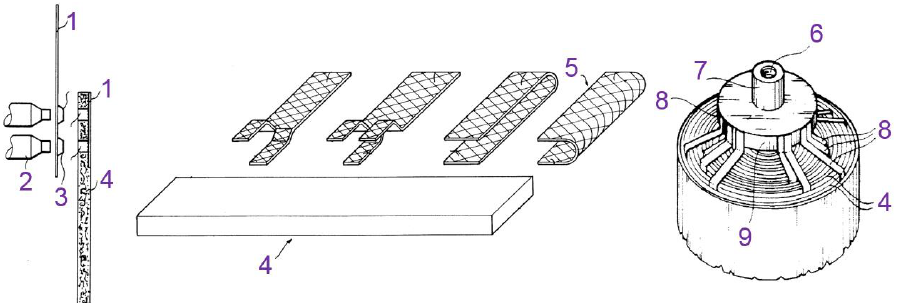
Figure 2. Schematics of three difference designs of current collectors by SAFT. The parts are 1: metal